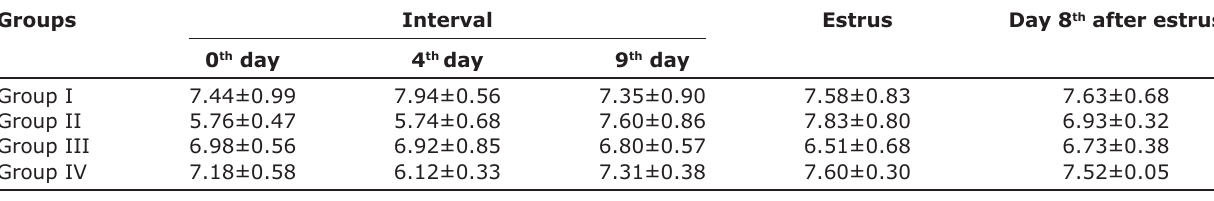
Table-4: Effect of herbal supplementation on mean serum inorganic phosphorus concentration (mg/dl) in various groups and intervals (ANOVA-one way).